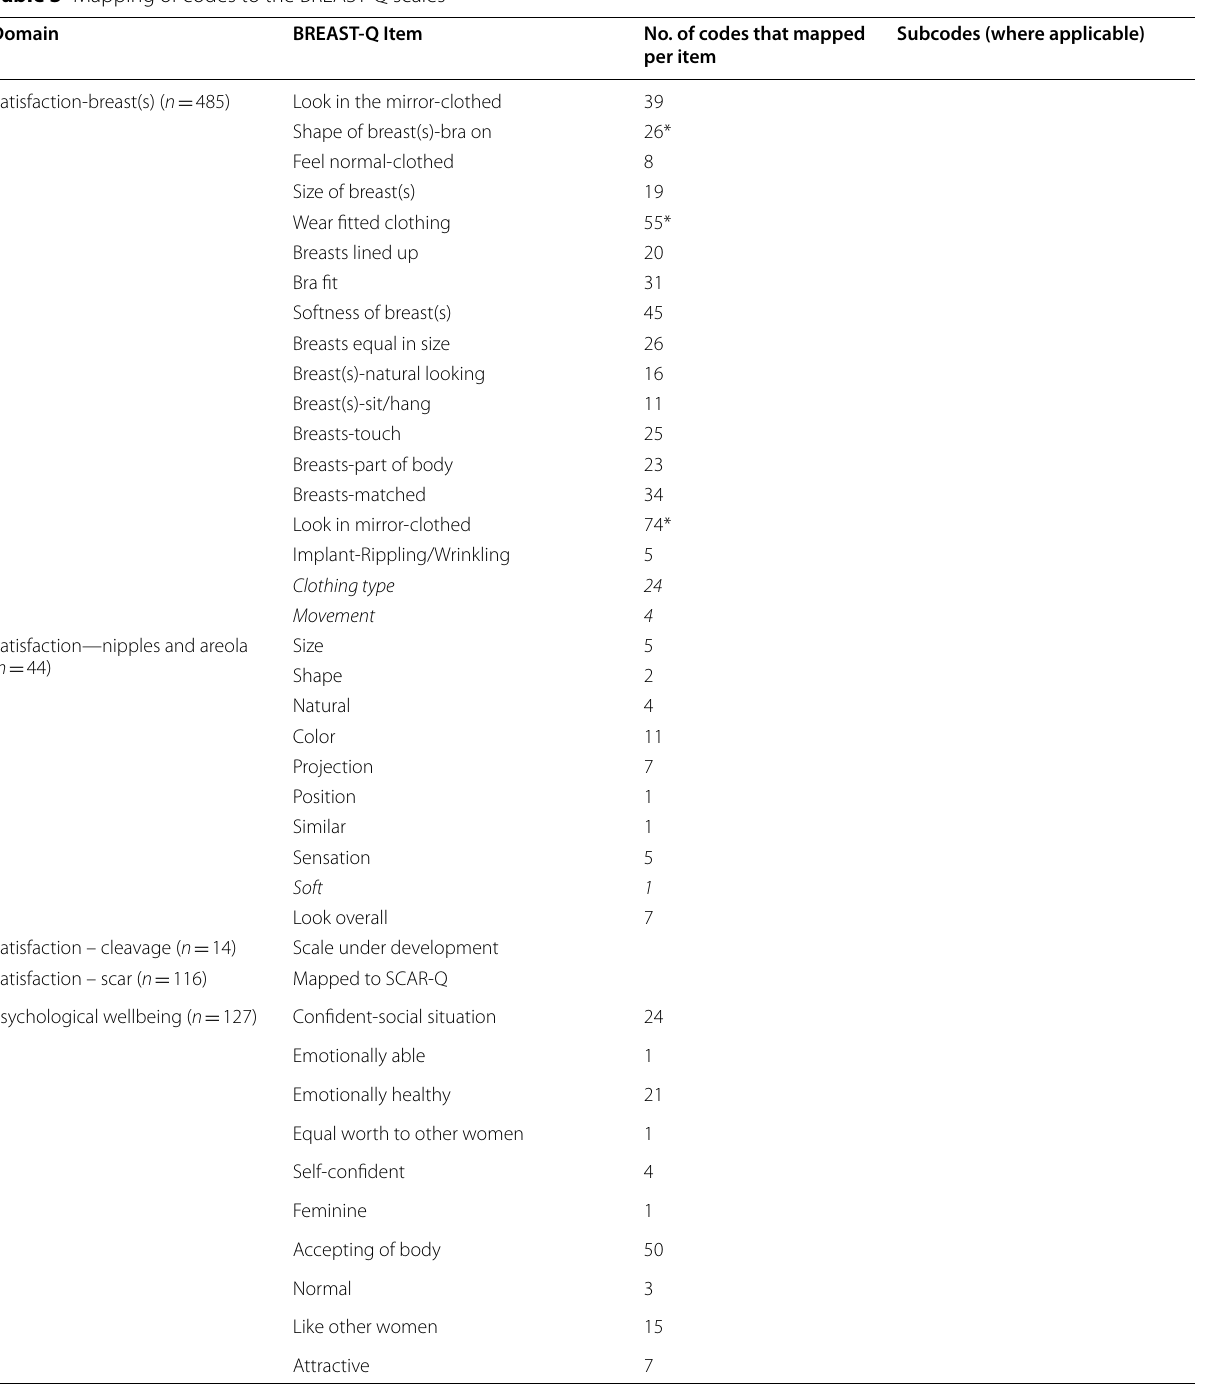
Table 3 Mapping of codes to the BREAST-Q scales